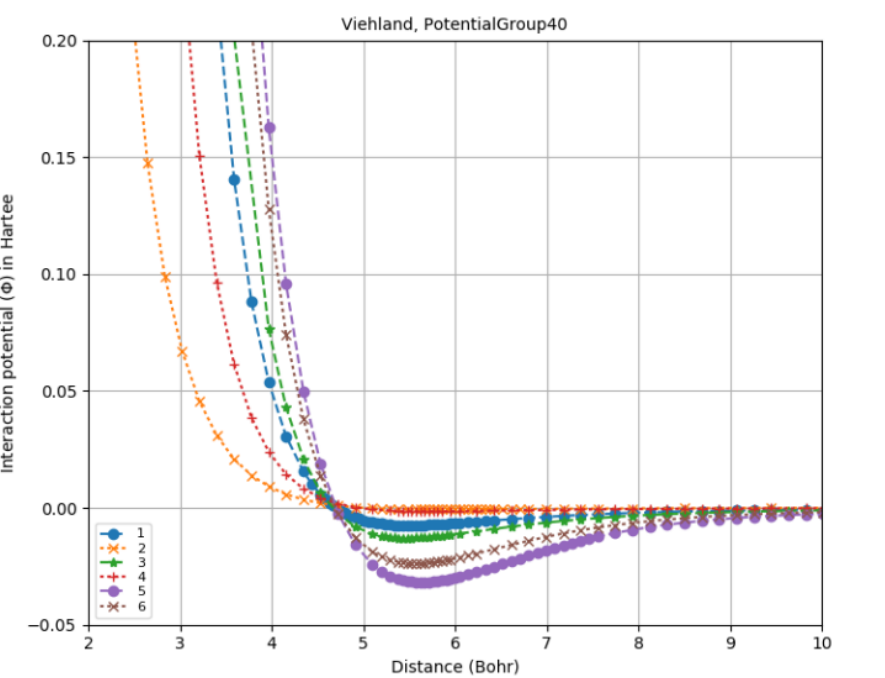
(cid:0) 2 (cid:1) S 1/2 (ground state ion) with the noble